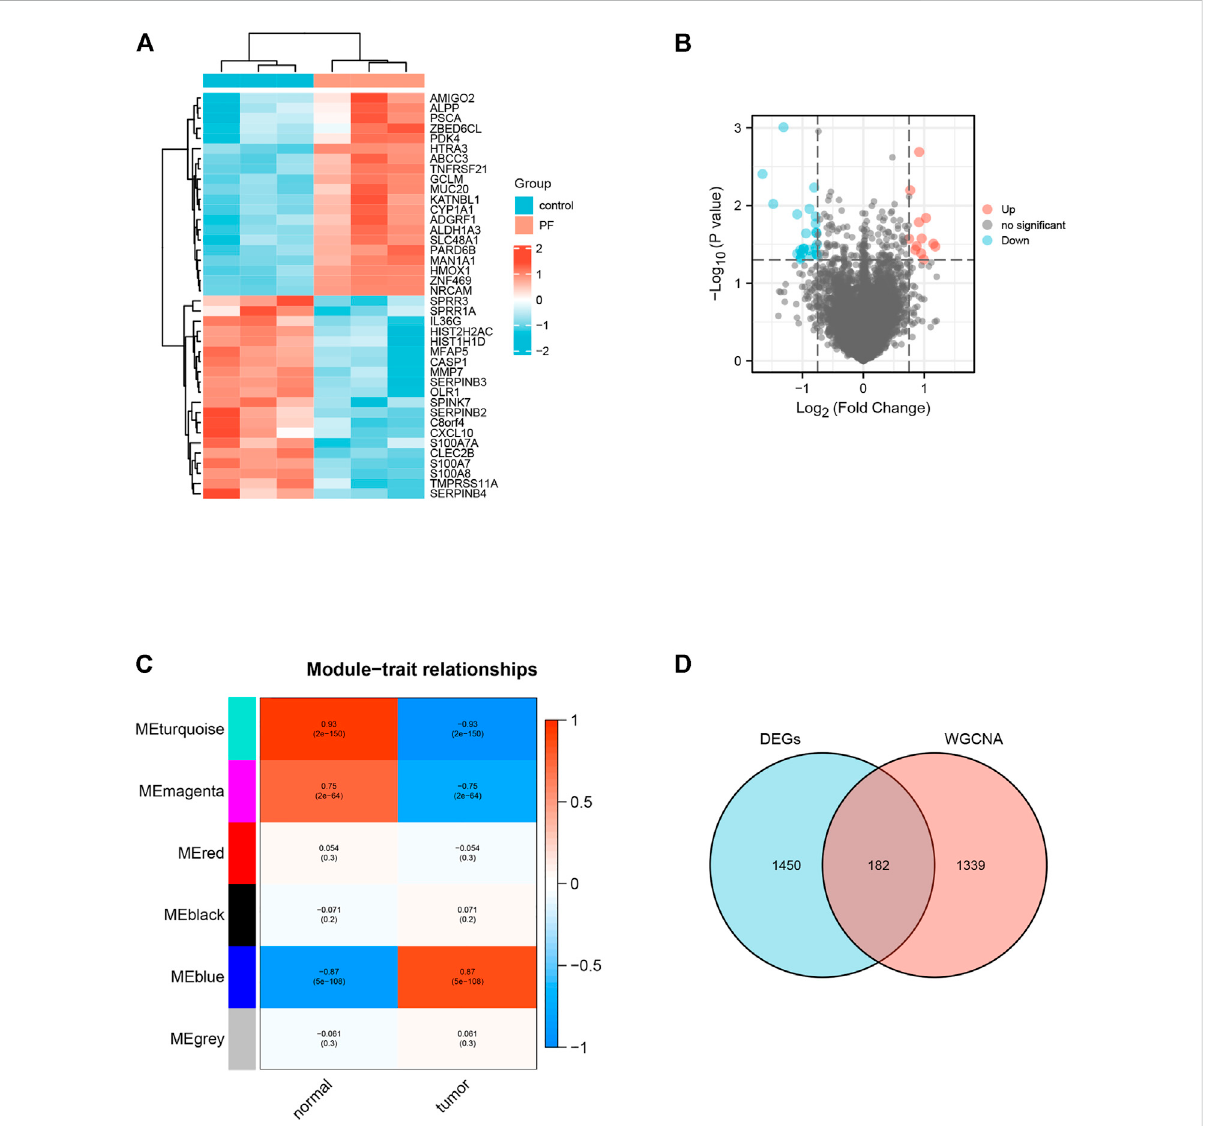
FIGURE 2 Identi fi cation of Target genes for paeoni fl orin treatment of pancreatic cancer. (A) Heatmap of the top 40 DEGs associated with Paeoni fl orin- treated pancreatic cancer. (B) The Volcano plot shows the distribution of genes that are differentially expressed (log2 fold change) compared to a measure of statistical signi fi cance( − log10 p -value) in theGSE97124 dataset. Genesthat were downregulated are shown in blue, whereas genes that were upregulated are shown in red. (C) The results show a highly signi fi cant correlation between GS and MM in the MEblue module. (D) Genes screened by DEGs (pink circles), genes in modules strongly connected to PF in WGCNA analysis (blue circles), and portions of these two classes of genes that overlap (purple circles).